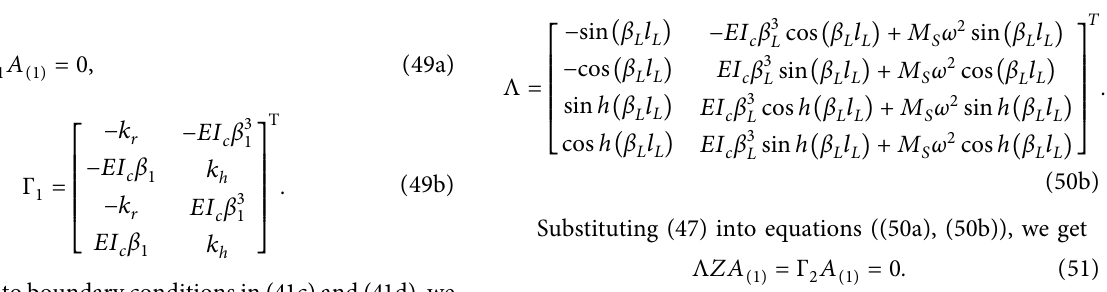
| / | U | with respect to l fs s